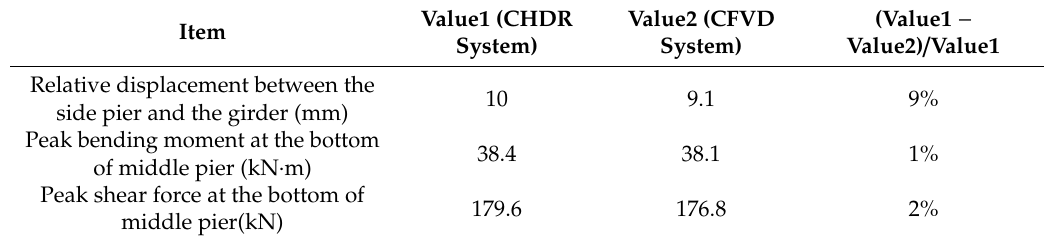
Figure 18. Comparison of hysteretic curves between the FVD and HDR. Table 5. Comparison of seismic responses of two systems.